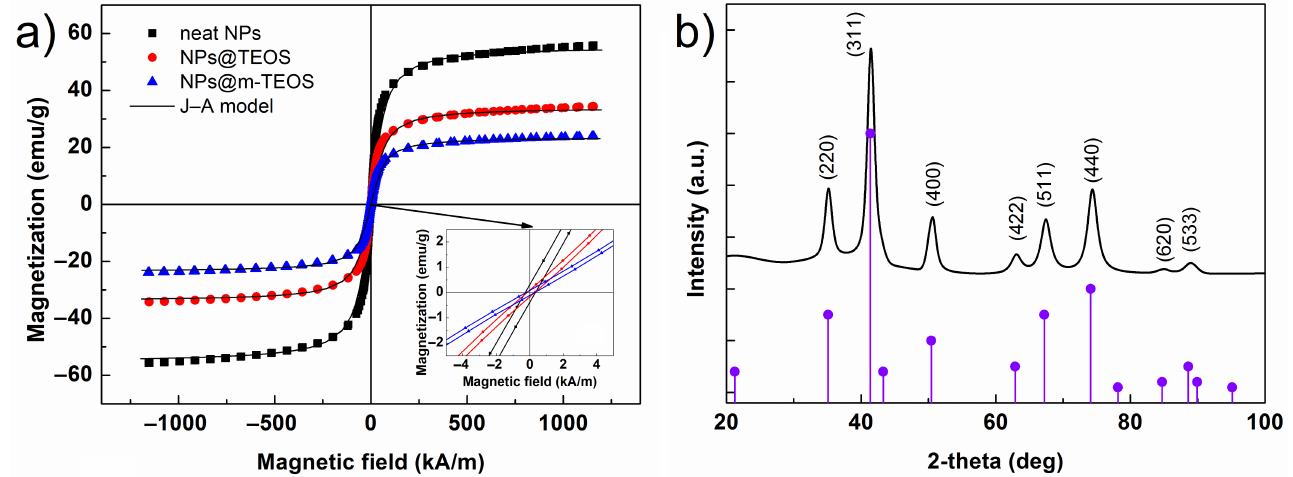
Figure 5. Isothermal VSM curves for the ( a ) neat NPs, NPs@TEOS and NPs@m-TEOS particles; the inset shows a magnified view of the zero-field region; graph ( b ) describes the XRD spectrum for the neat NPs, with vertical bars representing the Bragg